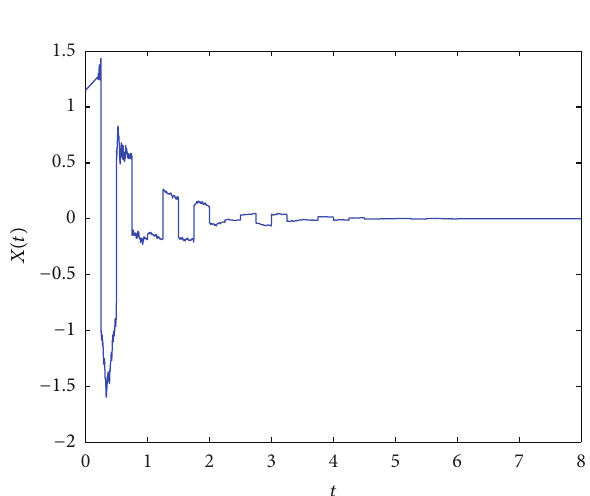
Figure 1: System without impulses for Example 1.